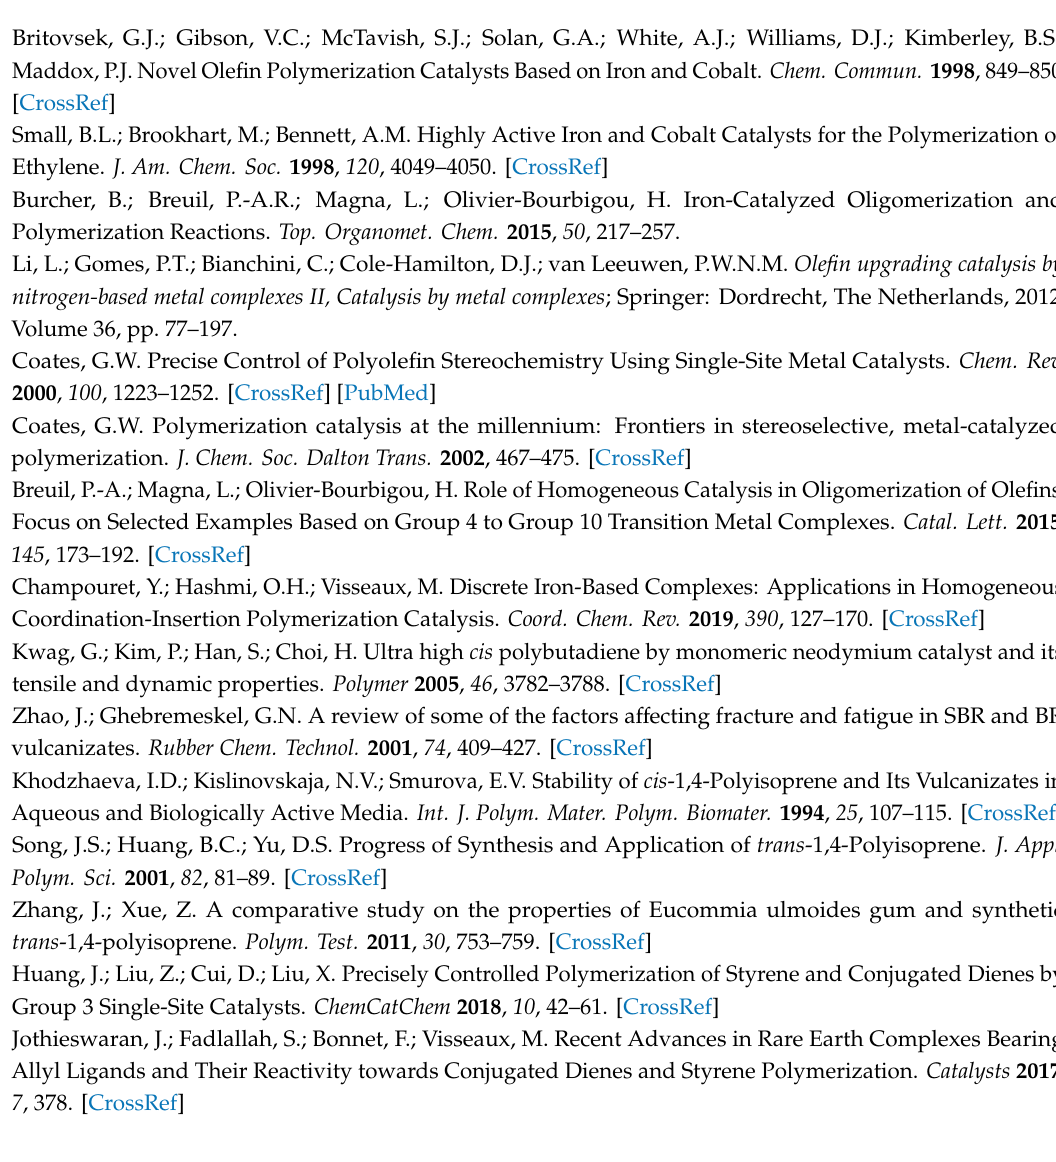
of the ligand L6 ; Figures S4–S8: 1 H-NMR of the ligands L1-L5; Figures S9–S14: 1 H-NMR of the complexes C1 – C6 ; Figure S15 : 1 H-NMR spectra of stacked of all iron-based complexes; Table S1: Polymerization of isoprene using C1 – C6 / AlEt 3 / [Ph 3 C][B(C 6 F 5 ) 4 ] (1 / 10 / 1) catalytic systems; Table S2: Polymerization of isoprene using C1 – C6 / MAO (1 / 500) catalytic systems; Table S3: Polymerization of isoprene using C1 – C6 / Al i Bu 3 / [Ph 3 C][B(C 6 F 5 ) 4 ] (1 / 3 / 1) catalytic systems; Table S4: Polymerization of isoprene (2500 eq.) using C4 / MAO (1 / 500) catalytic systems; Figure S16: Kinetic Profile of Polymerization with complexes C1 – C4 ; Table S5: Polymerization of 5,000 equiv. of isoprene / Fe using C1 – C4 / Al i Bu 3 / [Ph 3 C][B(C 6 F 5 ) 4 ] catalytic systems; Figures S17–S53: 1 H- and 13 C-NMR spectra of the polymers obtained; Figure S54: SEC traces of the polymers